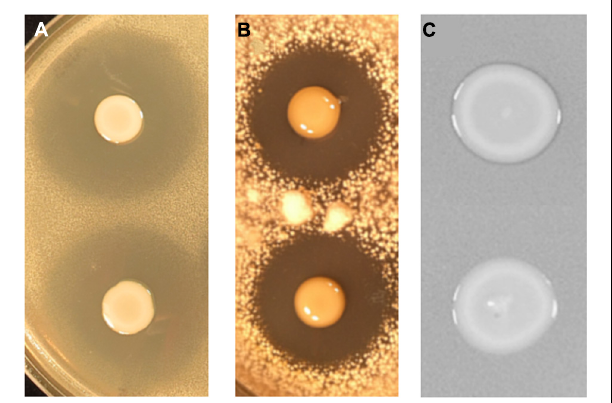
FIGURE 3 | Serratia plymuthicaA153 mutants that show reduced virulence in C. elegans are specifically attenuated for zeamine production. Plate-based bioassays showing andrimid (A) oocydin A (B) and zeamine (C) production. (A,B) The upper culture spot shows the A153 wild-type whereas the lower culture spot shows the derived mutant A153Ce10. (C) The upper culture spot shows the A153 (cid:2) andR mutant A153A whereas the lower culture spot shows the derived mutant A153Ce10A, which is representative of all mutants characterized in this study. In all cases, plates were incubated at 25 ◦ C either overnight (A,C) or for 5 days (B) .